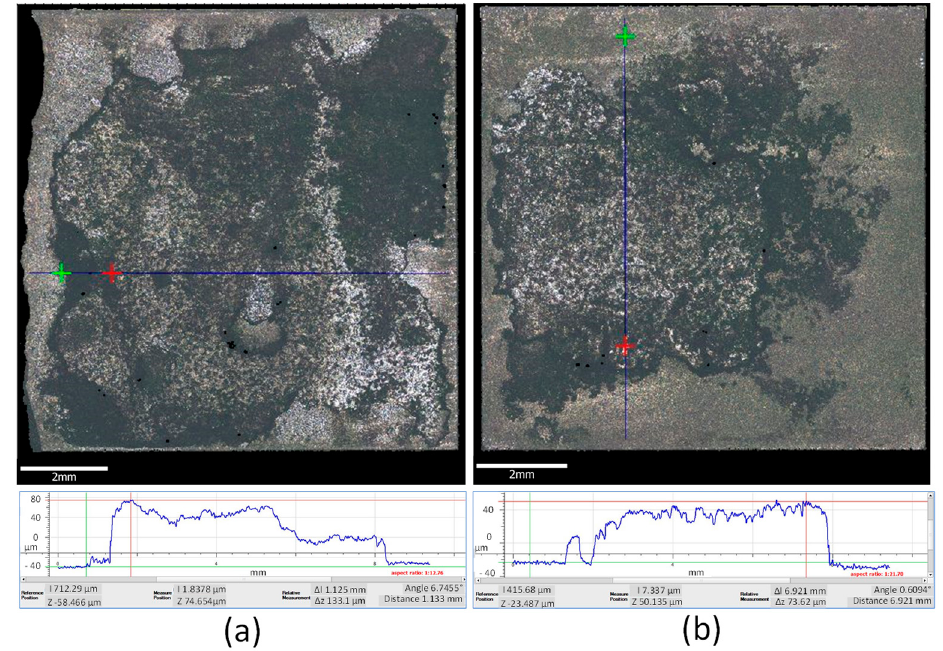
Figure 5. Focus variation microscopic thickness measurement of: ( a ) Test A, ( b ) Test B. Test C produced an average thickness of 95.13 μ m and a maximum thickness of 172.1